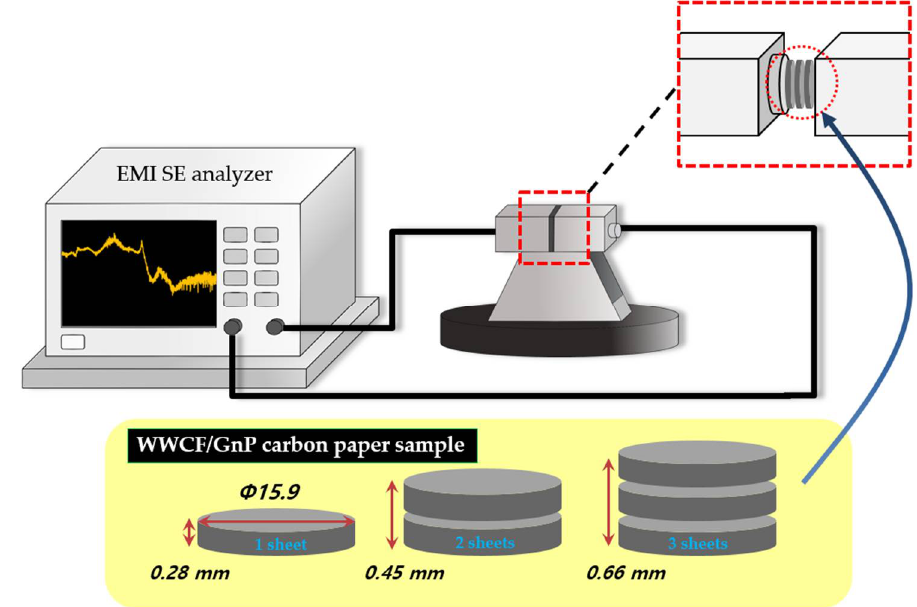
Figure 2. Apparatus of electromagnetic interference (EMI) shielding (EMI SE, EMI shielding effectiveness; WWCF/GnP, waste wood cellulose fiber/graphene nanoplatelet).